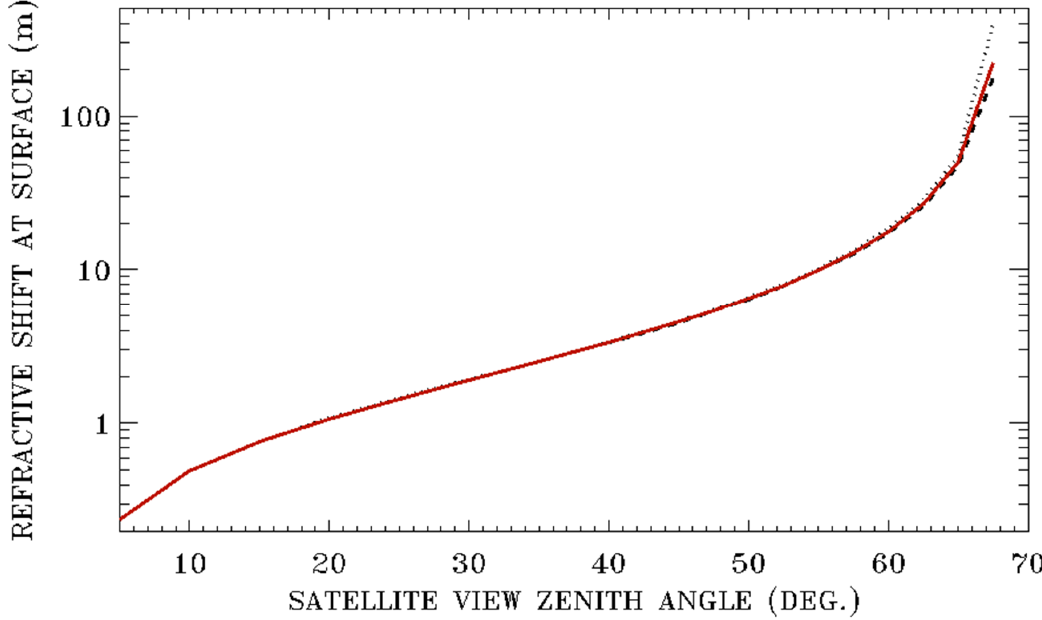
Figure 4. From the top to bottom curves—refractive surface pixel shifts as a function of satellite downward viewing angles for the sub-arctic winter, US 1976 standard, and tropical models, respectively. The calculations are made for green light at 550 nm and a satellite altitude of 500 km.